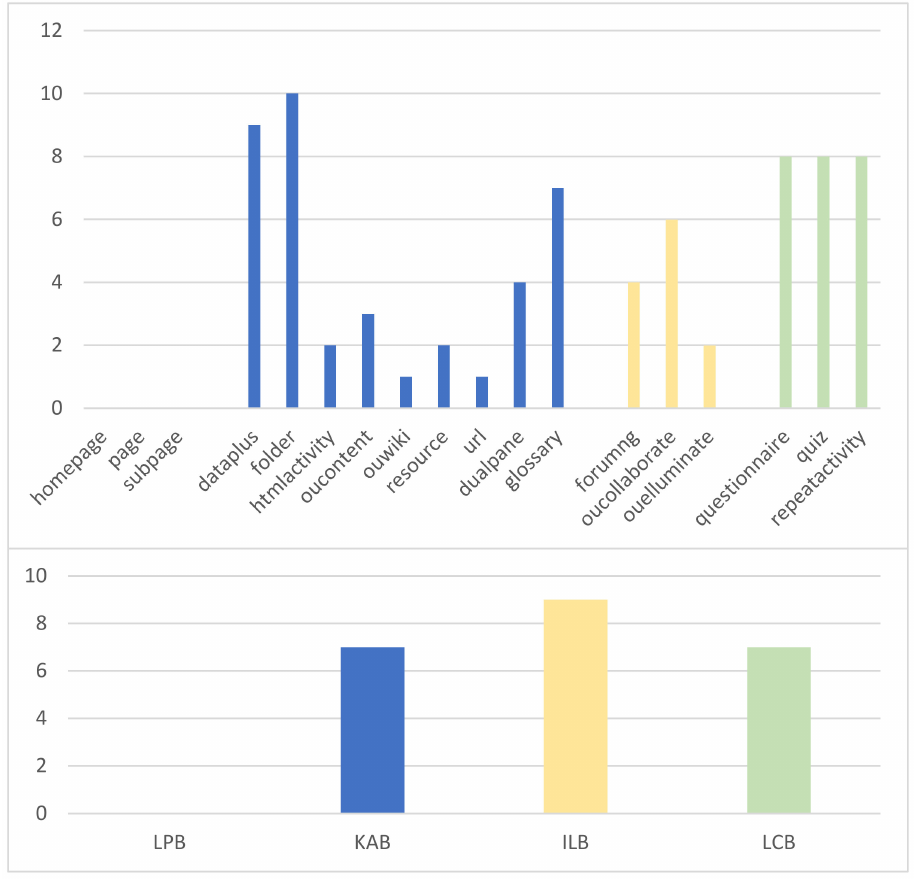
Figure 7. Diagram of accumulative feature space of SA-FEM 10-time running results. Table 8. Comparison of accuracy with existing benchmark